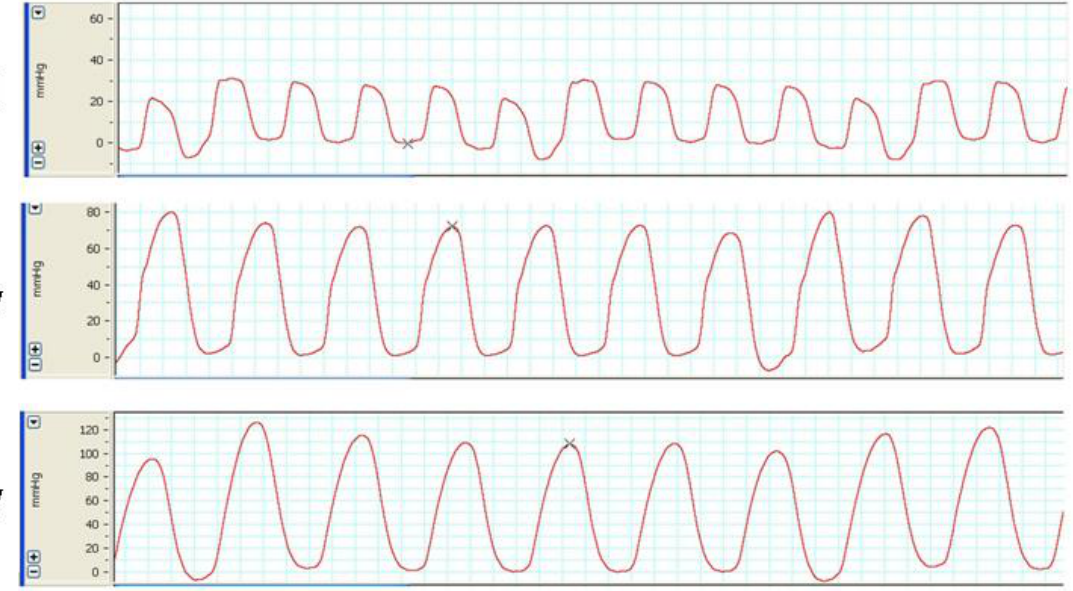
Figure 2. Right ventricle systolic pressure in rat PAH models.